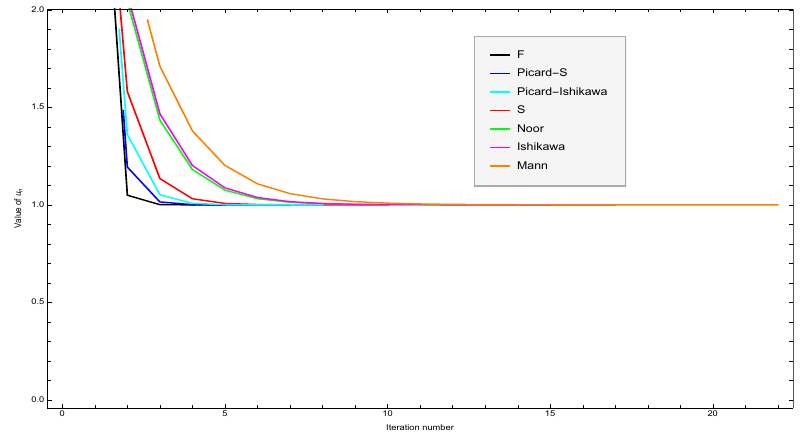
Figure 1. Different colors are assigned to show the behaviors of some of the